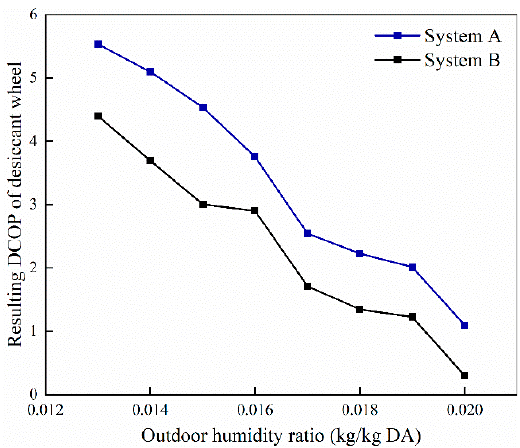
Figure 14. Relationship between the DCOP of the desiccant wheel and the outdoor humidity ratio.